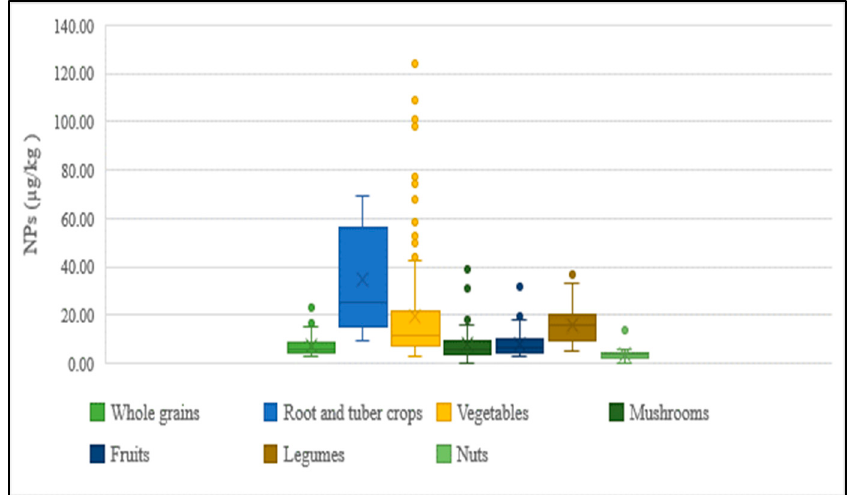
Figure 6. Concentration of NPs in agricultural products.